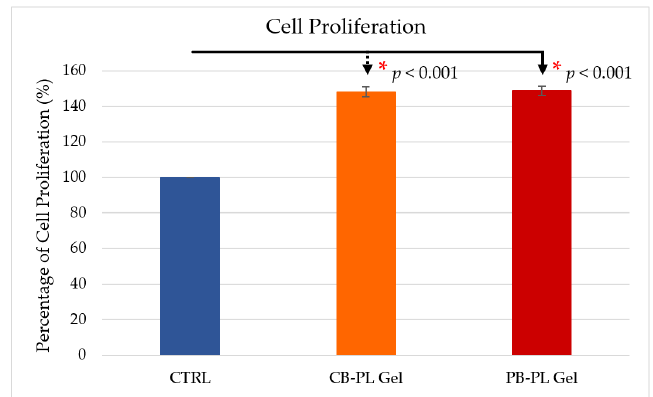
Figure 1. The cell proliferation percentages for CB-PL and PB-PL were computed relative to the serum-free medium/CTRL, which was set as 100% for normalization. The data were reported as means ± SEM of six independent samples ( n = 6). The statistical significance of CB-PL gel and PB-PL gel in comparison to CTR was indicated by * p < 0.05.